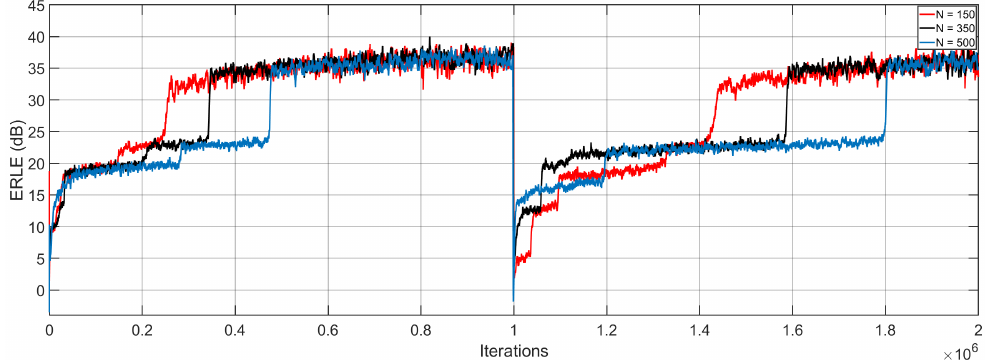
Figure 5. ERLE level for different number of coefficients N